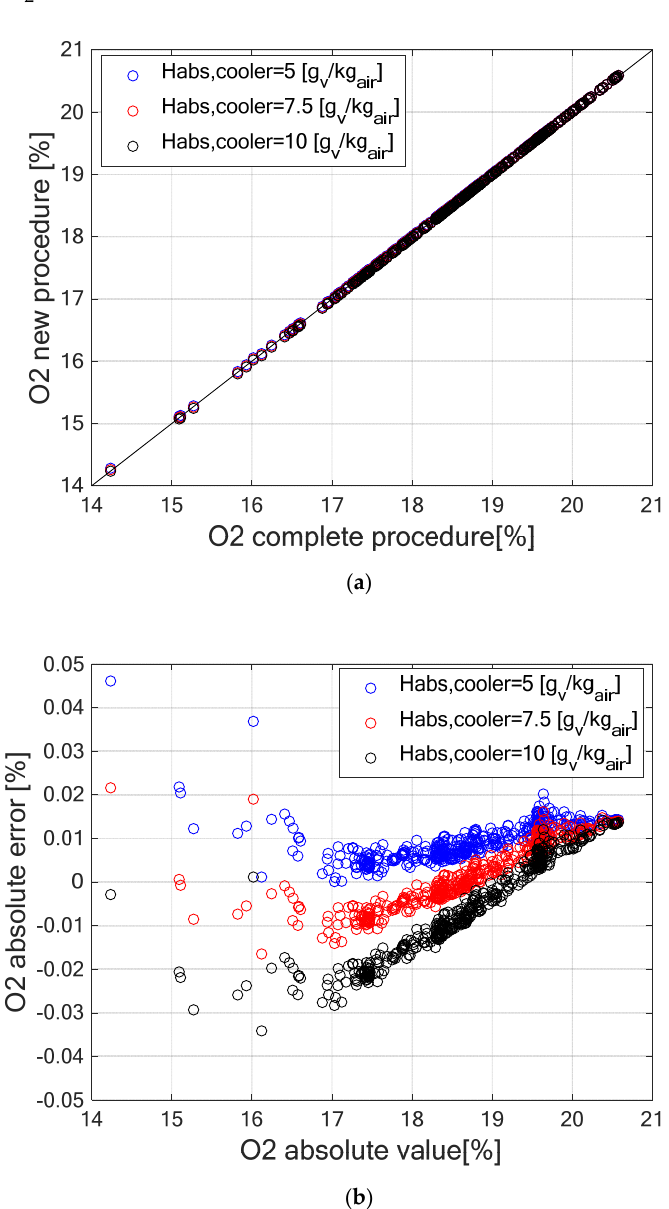
Figure 6. ( a ): Wet-intake O 2 concentration values predicted with the newly developed procedure vs. the values obtained using the detailed procedure reported in [22] for dataset 1, considering different absolute humidity values in the gases exiting the CO 2 analyzer cooler. ( b ): Error provided by the complete procedure as a function of the intake O 2 concentration. The error is evaluated as the difference between the absolute values.